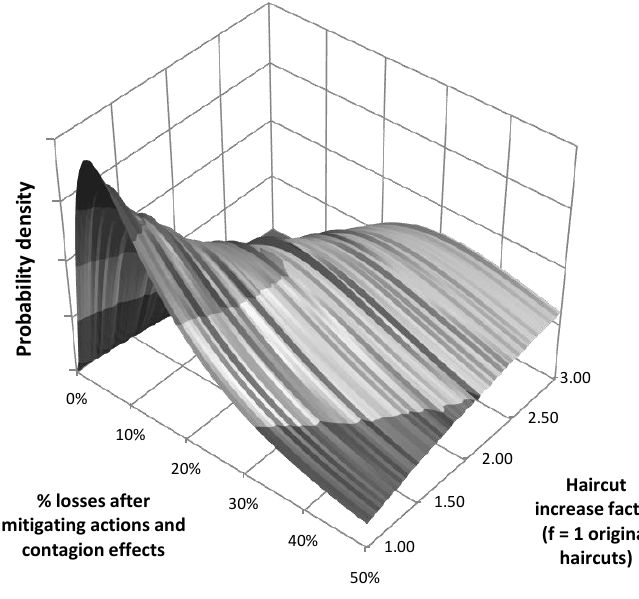
FIGURE 13: SA 2005, dependence of loss on haircut severity (buffer restoration) Source: